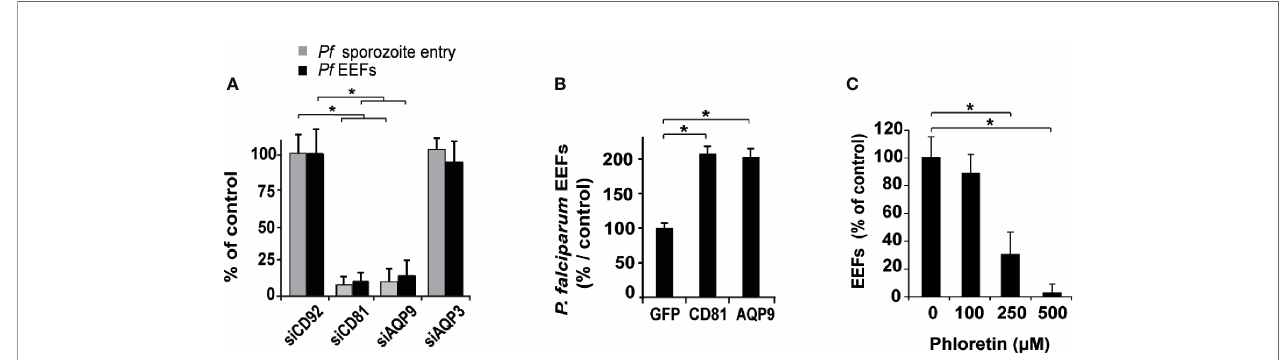
FIGURE 2 | Human hepatocyte permissiveness to P. falciparum sporozoite infection depends on AQP9 expression. (A) Hepatocytes were transfected with sihRNAs and tested for their permissiveness to P. falciparum sporozoite infection: sihCD92-, sihCD81-, sihAQP9 1 - and sihAQP3-transfected human hepatocytes were infected three days after transfection with P. falciparum sporozoites and cultured for 3 hours to evaluate sporozoite entry via double immunostaining for Pf CSP protein (grey bars) or for four days to evaluate cell infection after immunolabelling of EEFs using HSP70 antibody (black bars). Sporozoite and EEF numbers are expressed as a percentage of those in sihCD92-transfected control hepatocytes. * p = 0.0006. (B) Hepatocytes overexpressing CD81 or AQP9 were tested for their permissiveness to P. falciparum infection: hepatocytes transduced with a lentiviral vector expressing GFP protein, as a control, hCD81, or hAQP9 were infected three days later with sporozoites and cultured for four days until EEF quanti fi cation. EEF numbers are expressed as a percentage of those in GFP-transduced control hepatocytes. The mean schizont numbers per well in controls of three independent experiments were 141, 203, and 314. * p = 0.05. (C) Hepatocytes were treated for the fi rst two hours following sporozoite inoculation with three doses of phloretin. Hepatocytes were then washed and incubated with fresh complete medium for three additional days until EEF quanti fi cation. EEF rates are relative to those in untreated hepatocytes. * p = 0.0009. All analyses were carried out in triplicate wells, and the results are expressed as the mean ± standard deviation. p values were determined by Mann-Whitney U